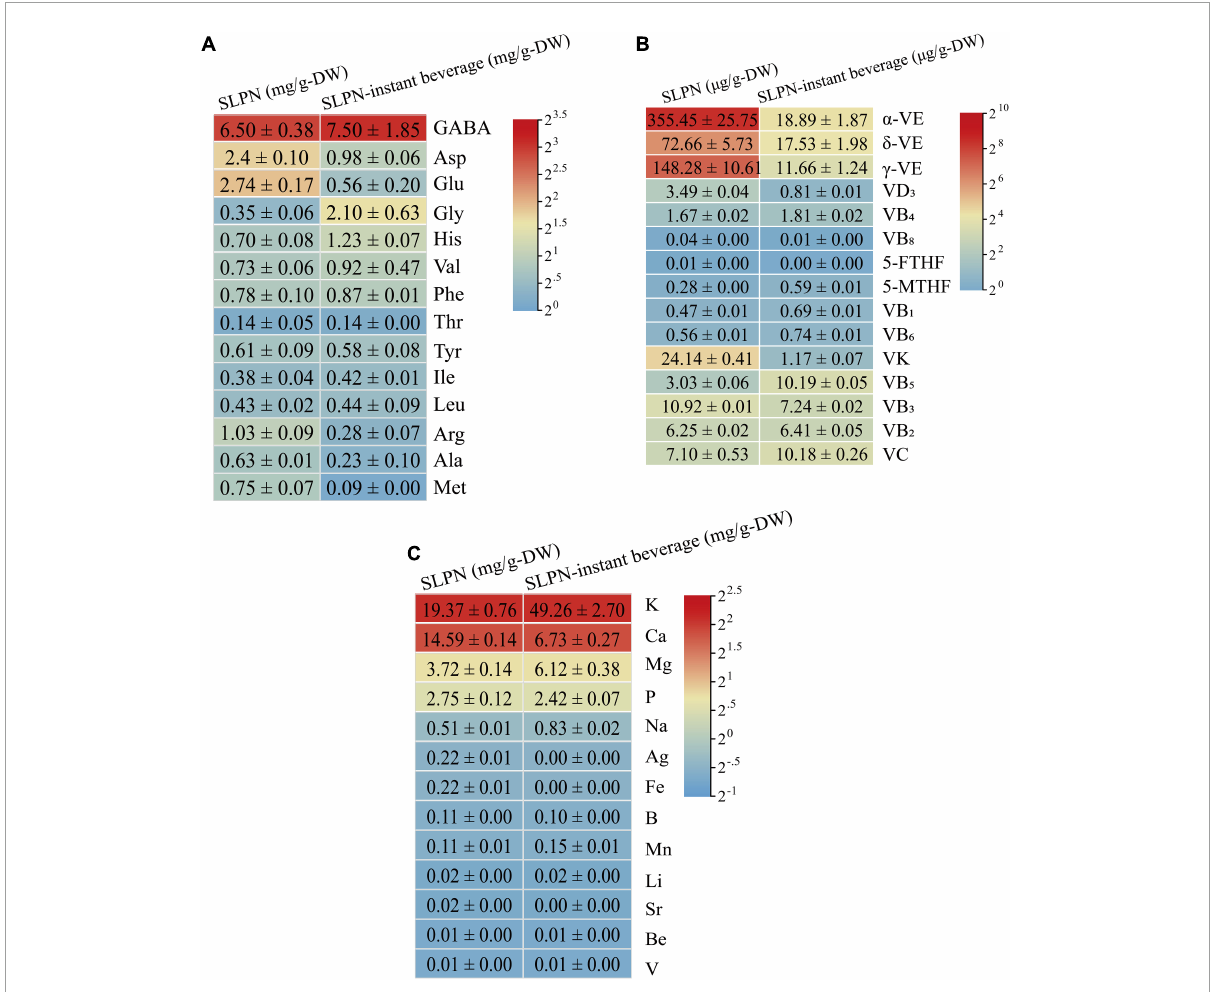
FIGURE4 The contents of (A) fourteen amino acids (B) fifteen vitamins and (C) thirteen mineral elements in SLPN and SLPN-instant beverage.